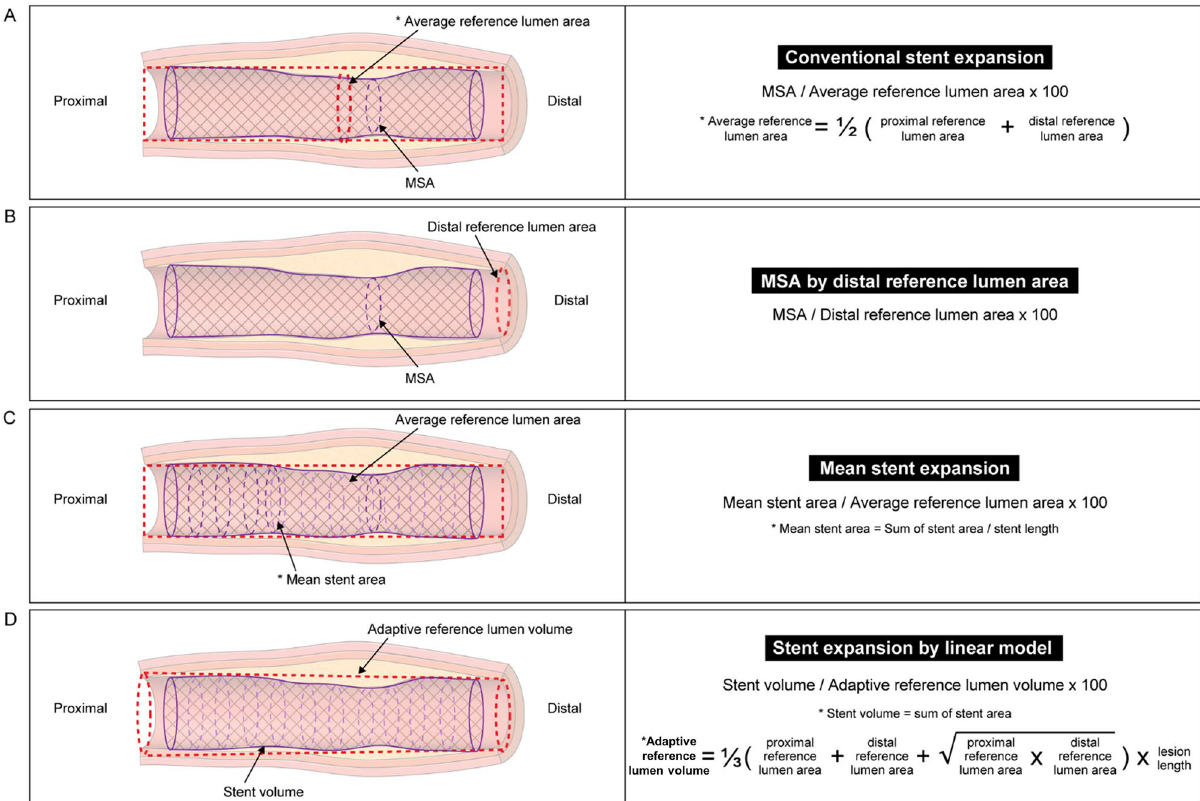
Figure 2. Stent expansion indices. ( A ) Conventional stent expansion, ( B ) MSA by distal reference lumen area, ( C ) mean stent expansion, and ( D ) volumetric stent expansion by linear model. MSA minimal stent